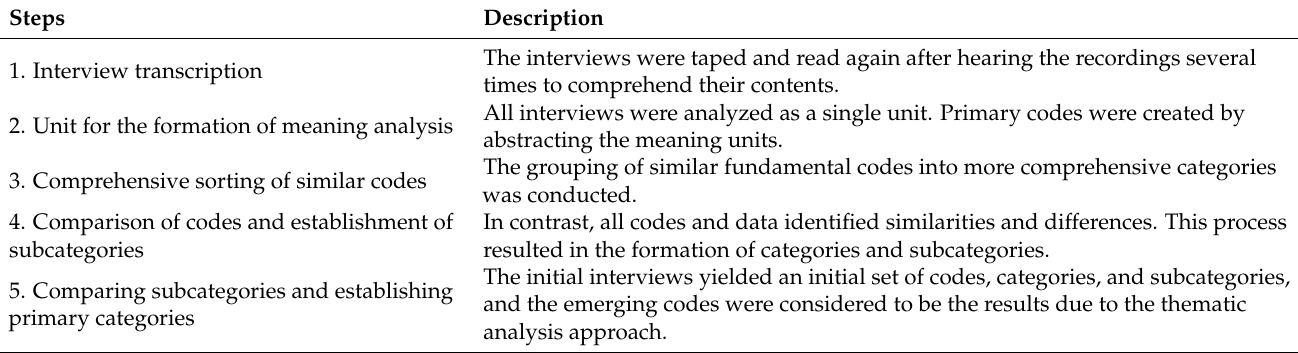
Table 3. Thematic data analysis procedure using Granheim and Lundman’s